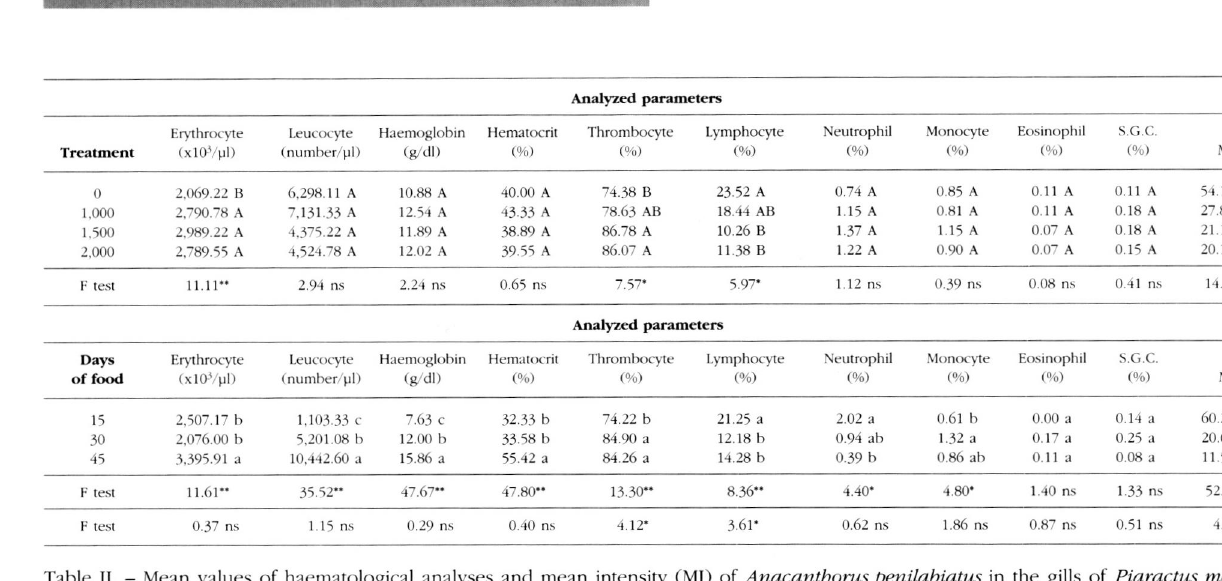
Table II. - Mean values of haematological analyses and mean intensity (MI) of Anacanthorus penilabiatus in the gills of Piaractus meso potamicus fed with garlic (T) for a period of 15, 30 and 45 days (D). Capital letters for comparison between treatments and minuscule let ters for the days of feeding (S.G.C: special granulocitic cell; * P < 0.05; ** P < 0.01; ns: not